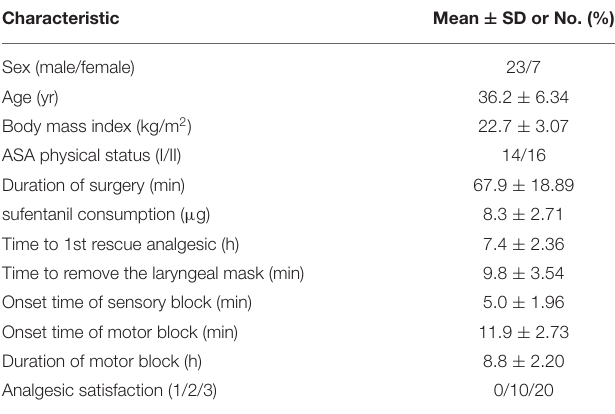
the motor block was 7.5 ± 1.32 h. No difference occurred in